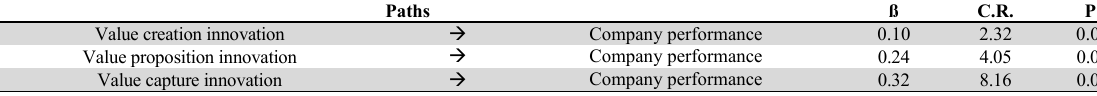
Results of hypotheses